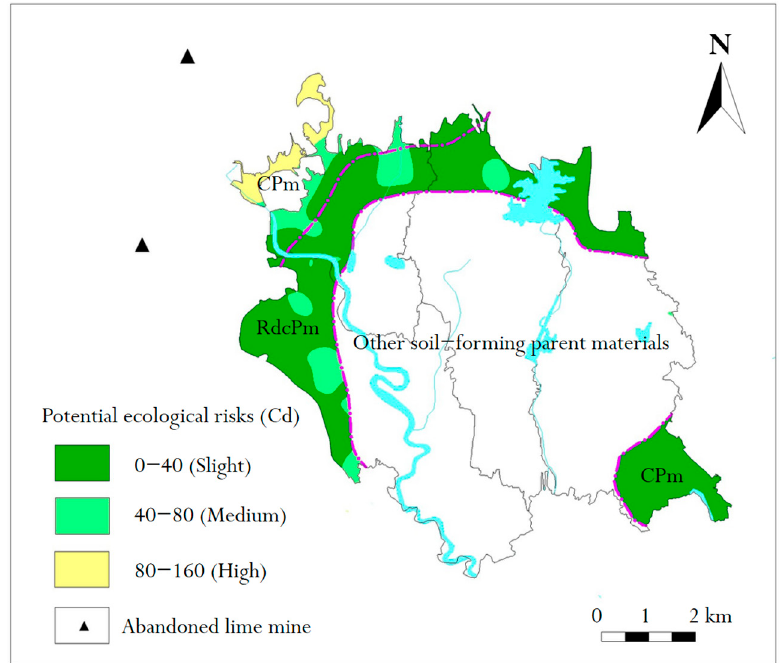
Figure 8. Distribution map of potential ecological risks of two soil parent materials.